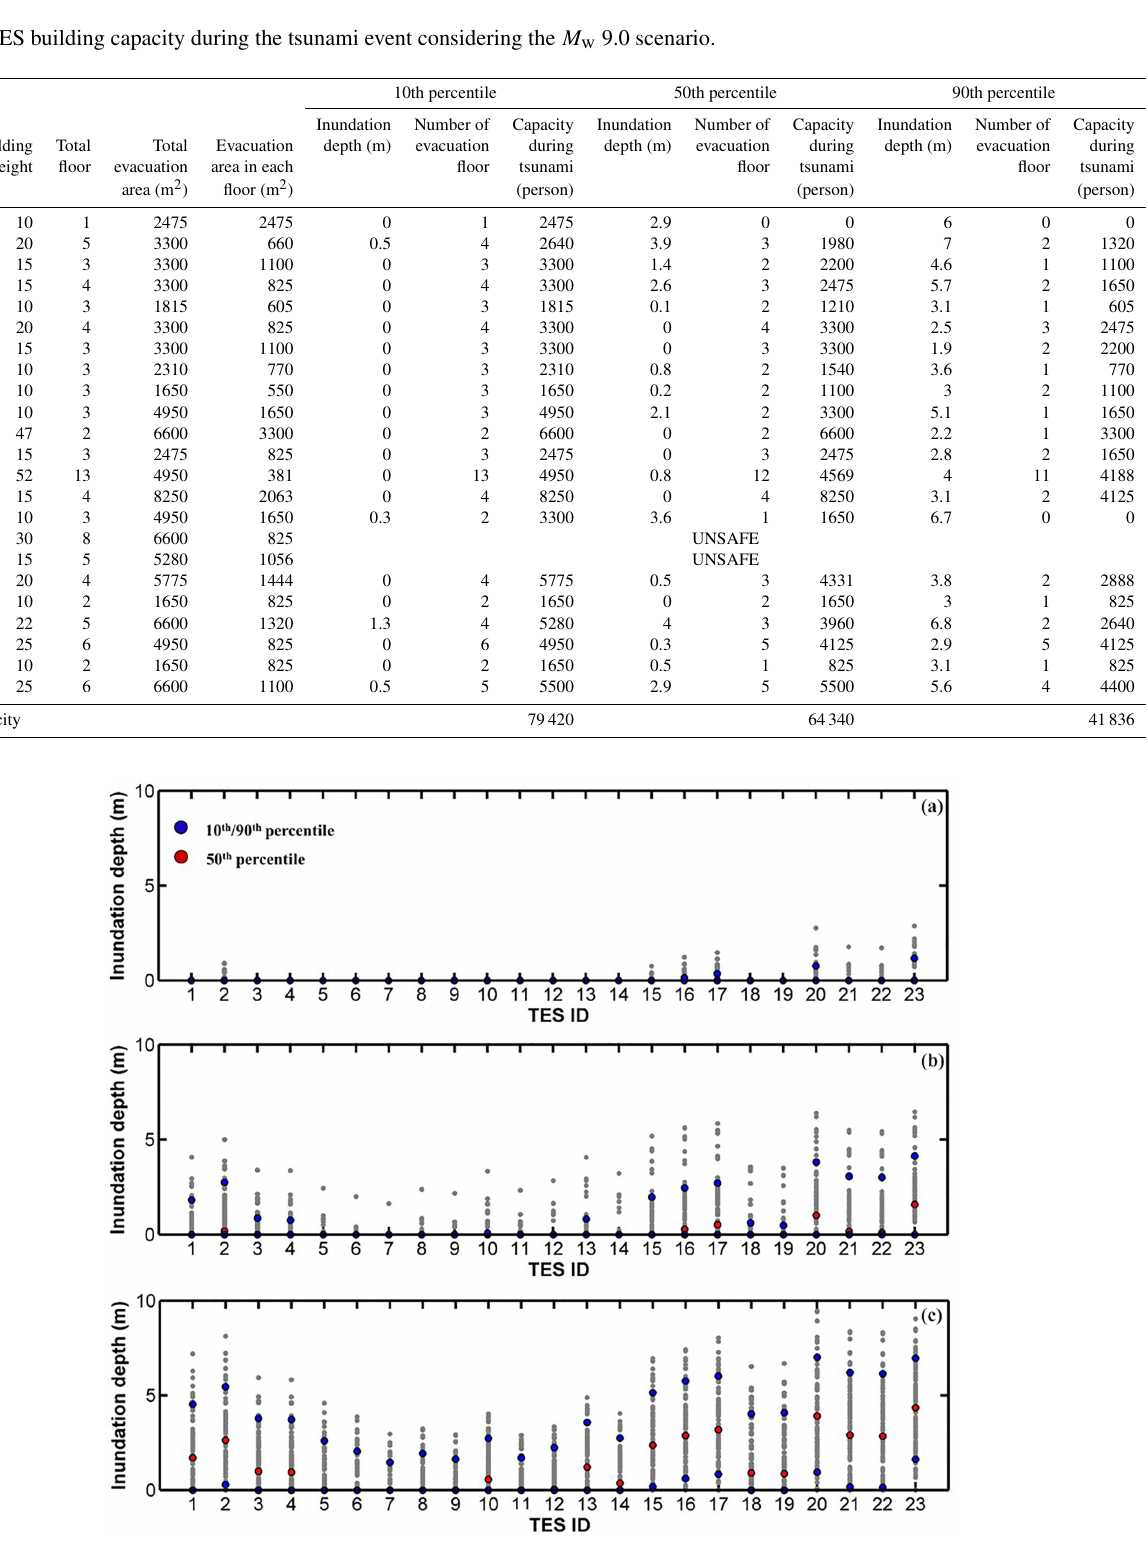
Figure 14. Inundation depth variability at TES stations for (a) M w 8.5 scenario, (b) M w 8.75 scenario, and (c) M w 9.0